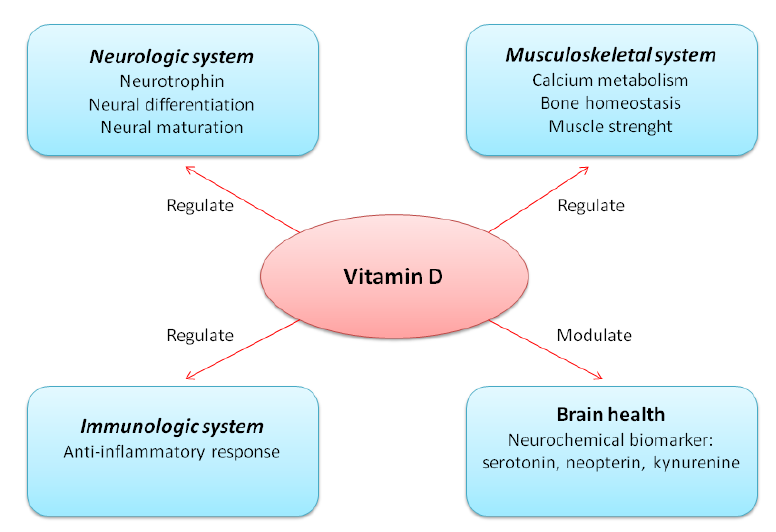
Figure 2. Role (regulation and modulation) of Vitamin D in neurologic, immunologic,